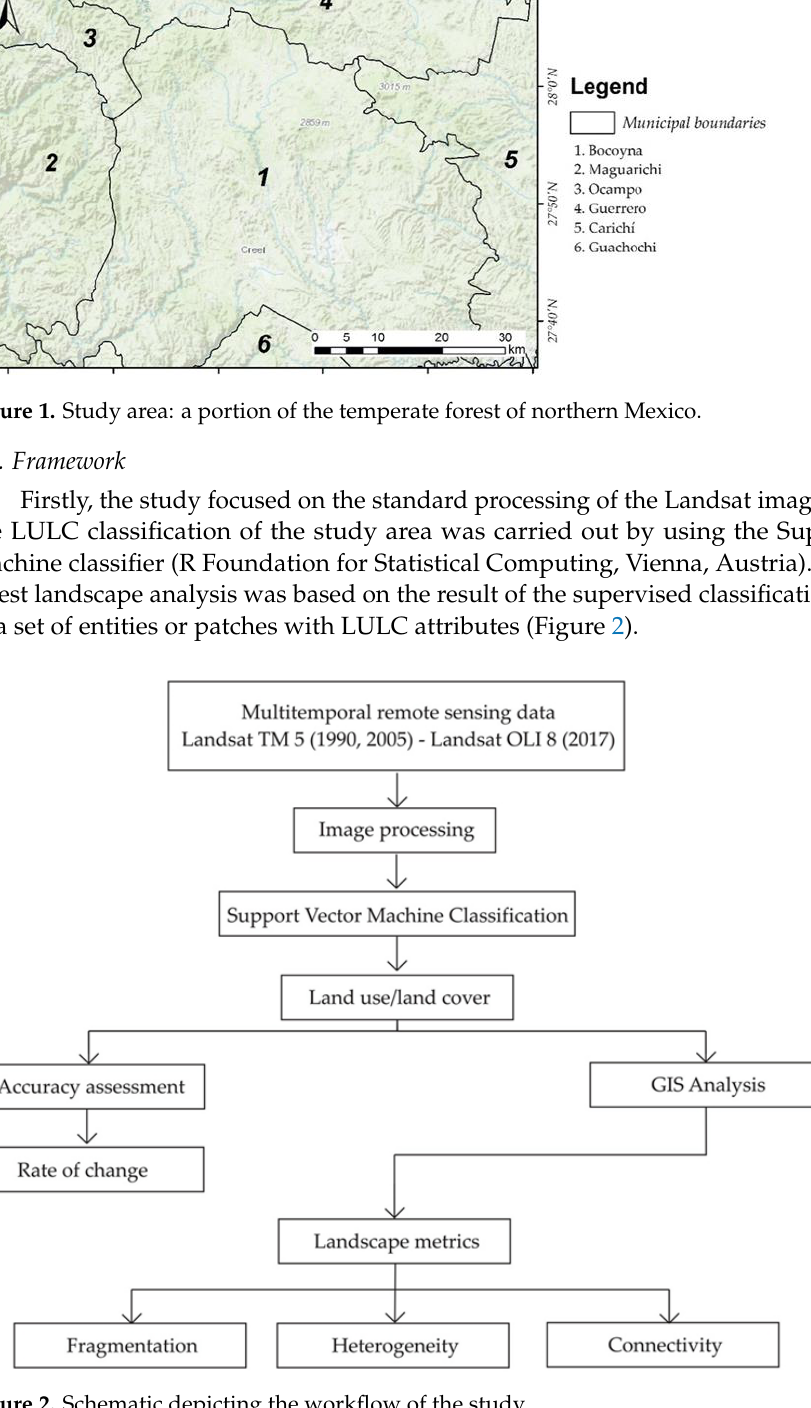
Figure 2. Schematic depicting the workflow of the study.